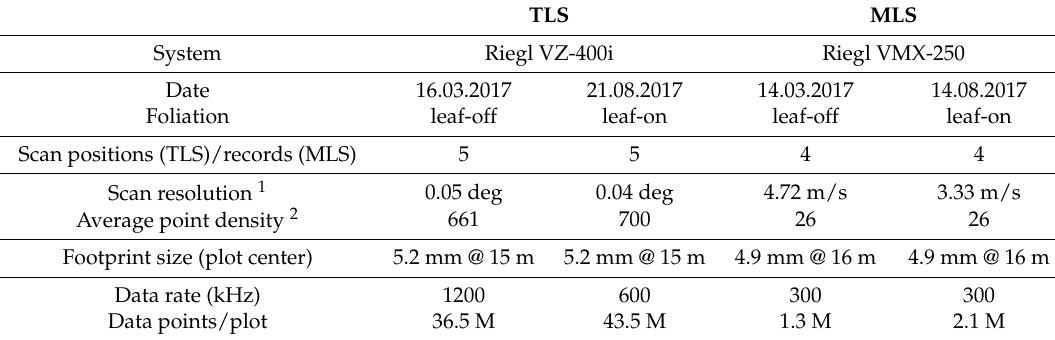
Table 1. Characteristics of the different datasets of the sample plots. 1 The scan resolution depends both on the data rate and on the speed of the mobile platform. 2 measured in a 10 cm × 10 cm point cloud slice of a stem facing the trajectory, located 2 m from the plot